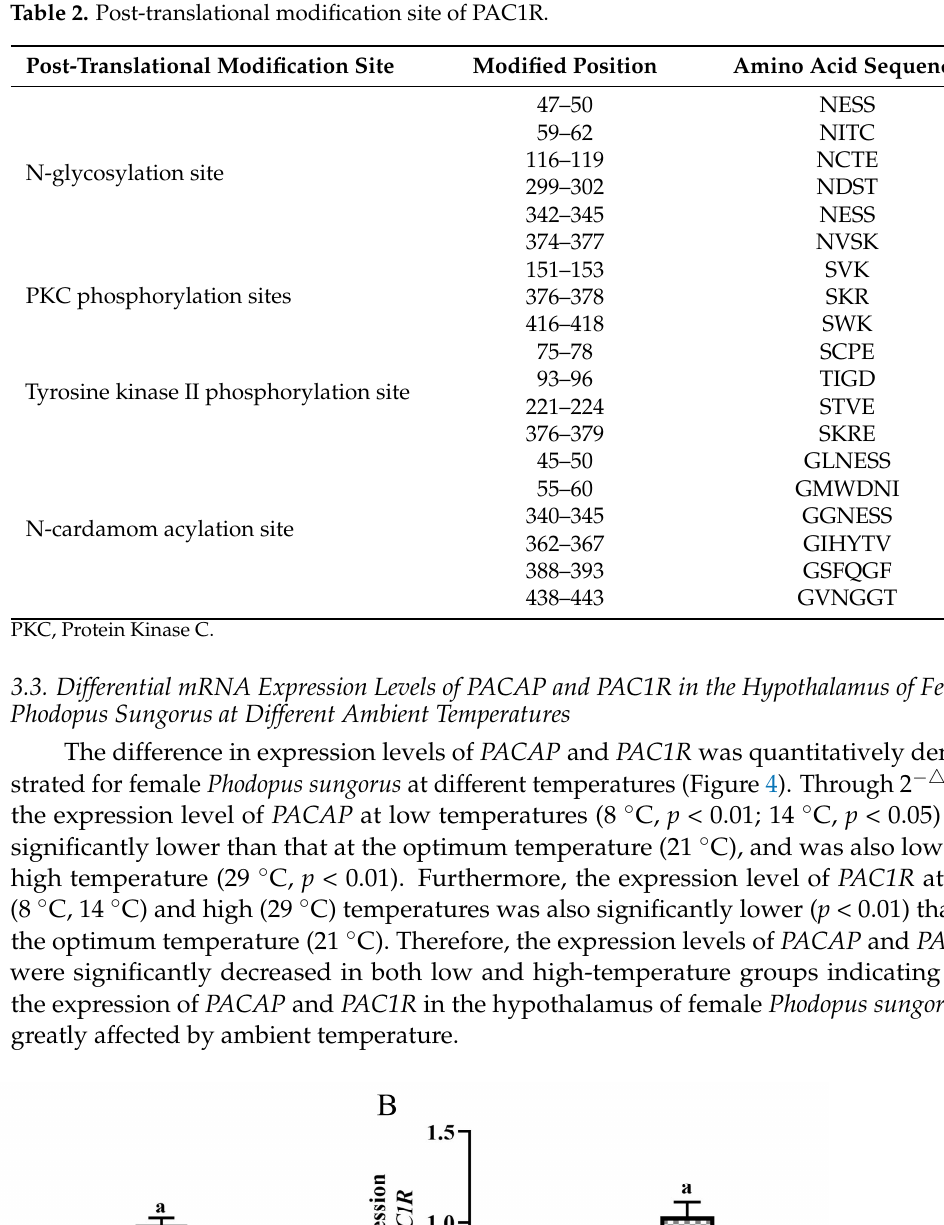
Table 2. Post-translational modification site of PAC1R.